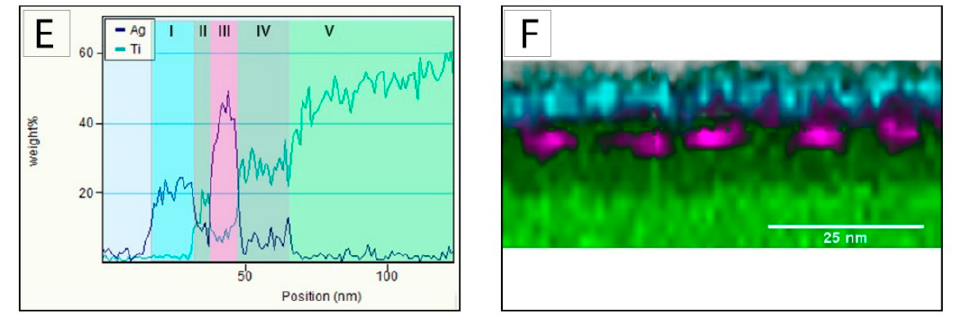
Figure 1. Optical micrograph of the U K-wire surface before ( A ) and after laser structuring ( B ); TEM of a cross-section (FIB) of the silver / titanium dioxide coating on titanium before ( C ) and after ( D ) 31 kGy gamma irradiation (coating composition: (I) surface marker, (II) titanium dioxide coating, (III) silver coating, (IV) titanium dioxide coating, and (V) titanium substrate); ( E ) energy-dispersive X-ray spectroscopy (EDX) line scan of a cross-section of the silver / titanium dioxide coating on titanium before gamma irradiation taken in vertical direction, and ( F ) EDX mapping after gamma irradiation: green represents titanium, purple is silver and cyan is platinum (surface marker).